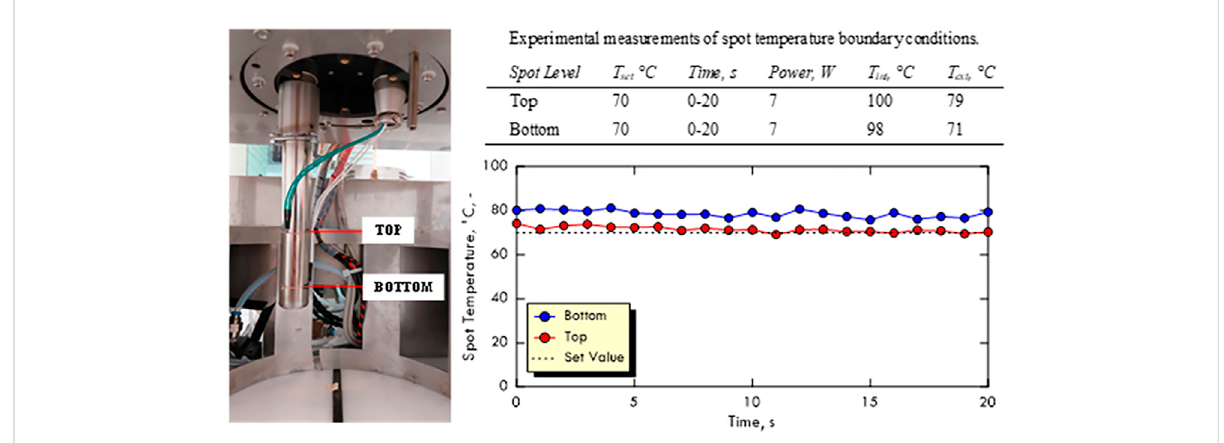
FIGURE 4 Experimental measurements of the time pro fi le of the spot temperature.Temperature is measured at different positions over the spot surface, namely top and bottom .